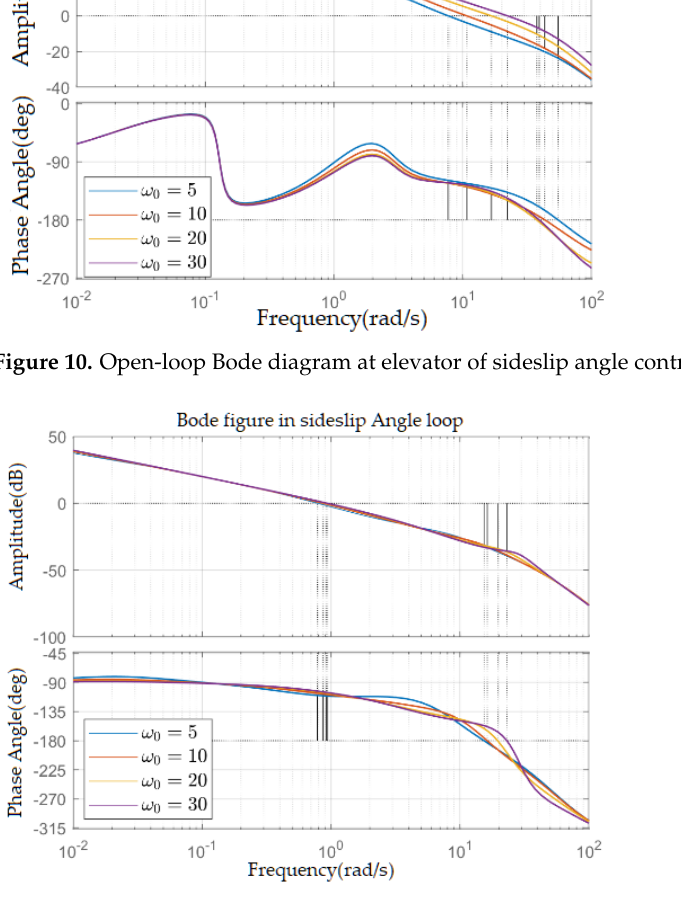
Figure 11. Loop Bode diagram of sideslip angle control